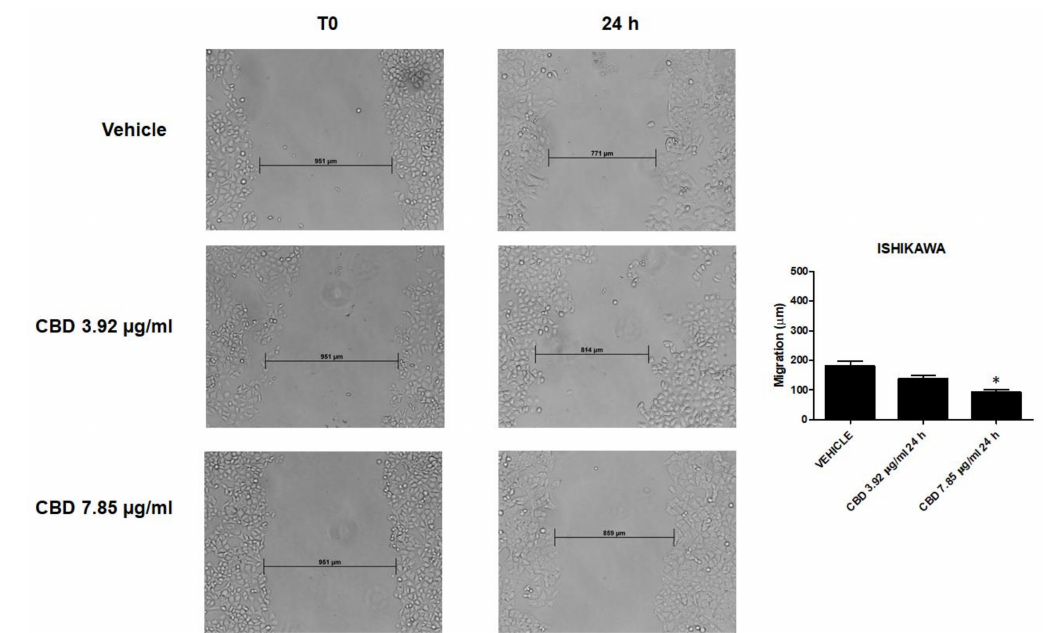
Figure 12. CBD treatment inhibited migration of Ishikawa cells. Wound-healing assays for Ishikawa cells after treatment with CBD 7.85 µ g / mL and 3.92 µ g / mL for 24 h. All experiments were repeated three times and images were taken at 0 and 24 h (20 × ). Data are presented as the mean ± SD. * p < 0.05 vs. untreated.